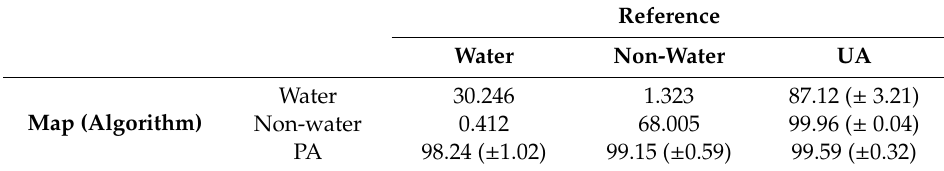
Table 1. The results of the accuracy and corresponding variance of water extraction from 2010 to 2015.